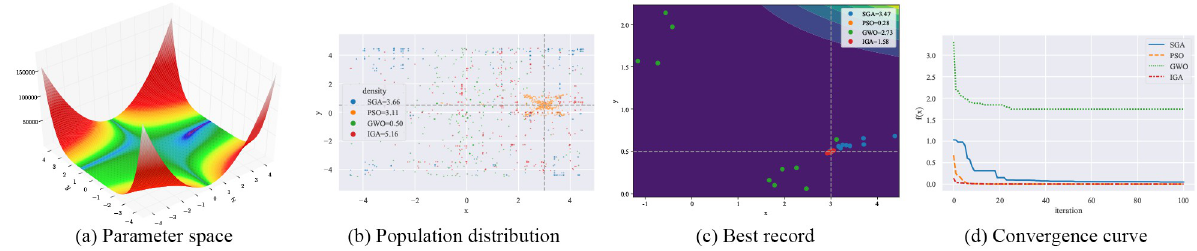
Fig 5. Qualitative results for the F14 function. (a) Parameter space. (b) Population distribution. (c) Best record. (d) Convergence curve.